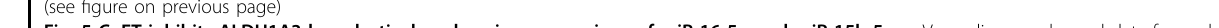
Fig. 5 CuET inhibits ALDH1A3 by selectively enhancing expressions of miR-16-5p and miR-15b-5p. a Venn diagram showed data for each database intersection. b The potential binding site for miR-16-5p (up) and miR-15b-5p (down) and the mutated sequence in the ALDH1A3 3 ′ UTR for the seed region were shown in blue. c Luciferase activity was measured in HCT116 and LoVo cells transfected with miR-16-5p, miR-15b-5p, miR-16- 5p/miR-15b-5p mixture mimics or control miRNA. The luciferase reporter plasmid expressing wild-type, mutant human ALDH1A3 3 ′ UTRs and empty vector (GV272) were used. The luciferase activity was normalized to the control miRNA. d Western blot of ALDH1A3 from HCT116 and LoVo cells transfected with miR-16-5p, miR-15b-5p, miR-16-5p/miR-15b-5p mixture mimics or control miRNA. e Western blot of ALDH1A3 from HCT116 and LoVo cells transfected with miR-16-5p, miR-15b-5p, miR-16-5p/miR-15b-5p mixture inhibitor or control miRNA. f Cell proliferation assay was performed in HCT116 and LoVo cells transfected with miR-16-5p, miR-15b-5p, miR-16-5p/miR-15b-5p mixture mimics or control miRNA. g Cell proliferation assay was performed in HCT116 and LoVo cells transfected with miR-16-5p, miR-15b-5p, miR-16-5p/miR-15b-5p mixture inhibitor or control miRNA. h , i Levels of miRNA-16-5p ( h ) and miRNA-15b-5p ( i ) were negatively correlated with the mRNA expression of ALDH1A3 in Jiuyuan cohort and TCGA cohort using linear regression analysis. Data are presented as the mean±SD of three independent experiments, ** p < 0.01, *** p <